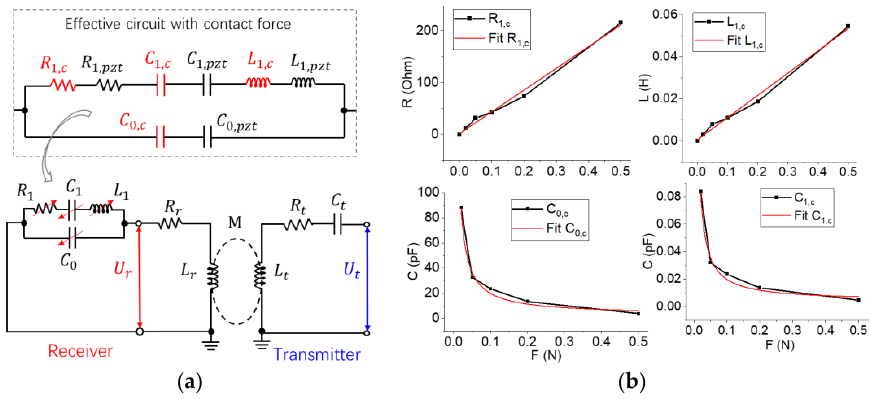
Figure 7. The electrical properties of a BAW passive wireless sensing system. ( a ) The circuit diagram of the system with lumped parameters. R 1, c , L 1, c , C 1, c , and C 0, c are the added lumped parameters because of the contact. ( b ) The influence of compression on the four added terms.